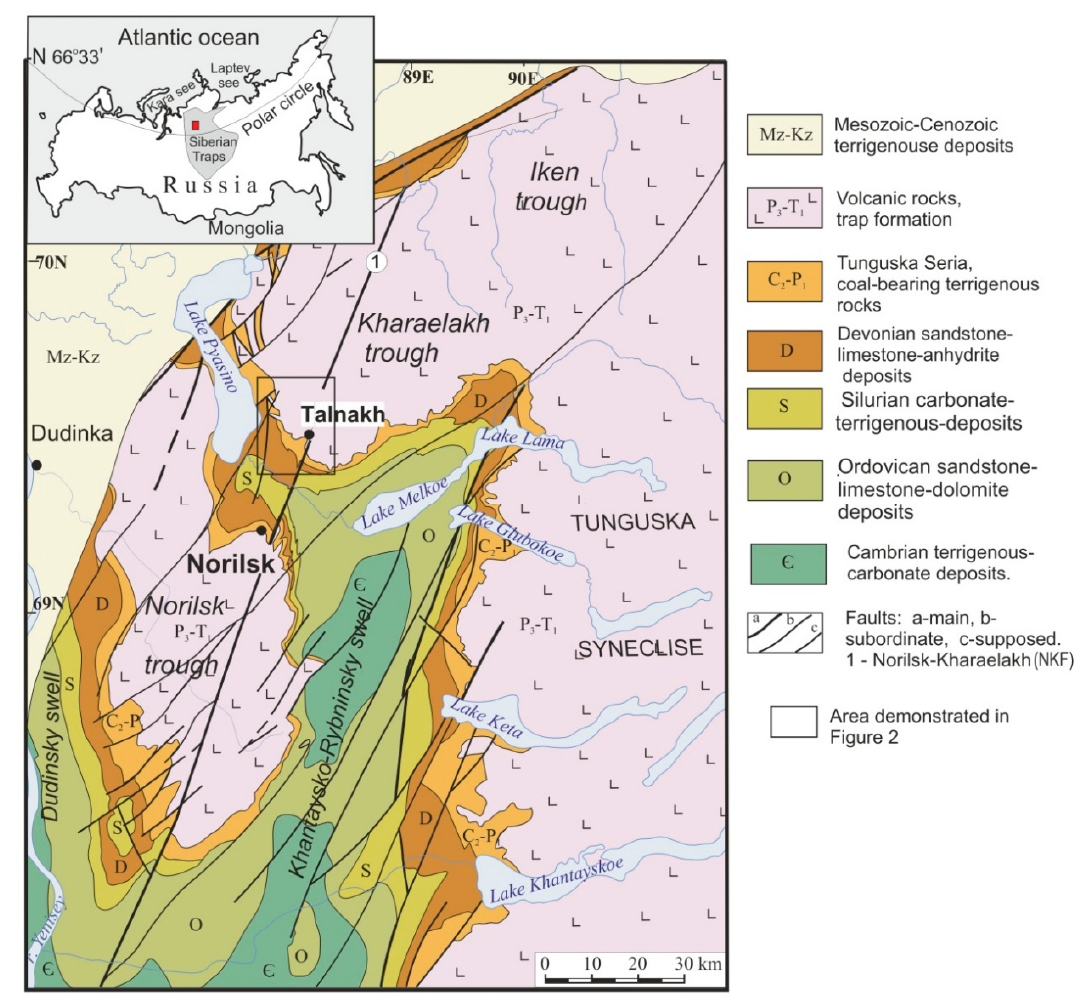
Figure 1. Schematic geological map of the Norilsk district (constructed by the authors based on [36]) with its position in Russia (red square) in inset.